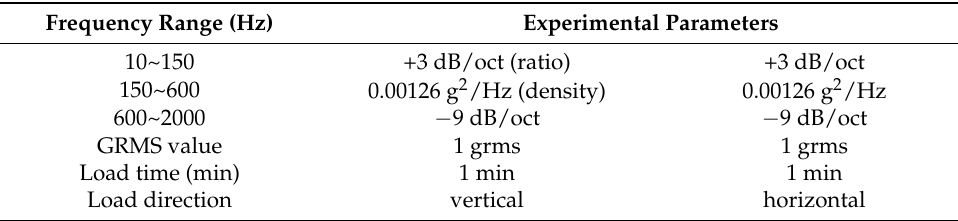
Figure 17. Vibration test results: ( a ) Sinusoidal vibration; ( b ) Random vibration. Table 2. Random vibration test conditions for system compression state.